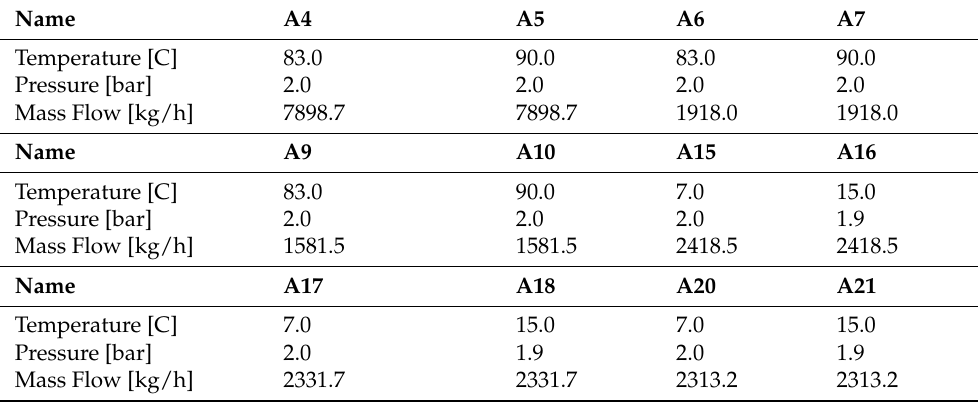
Table A11. States of the water flows in